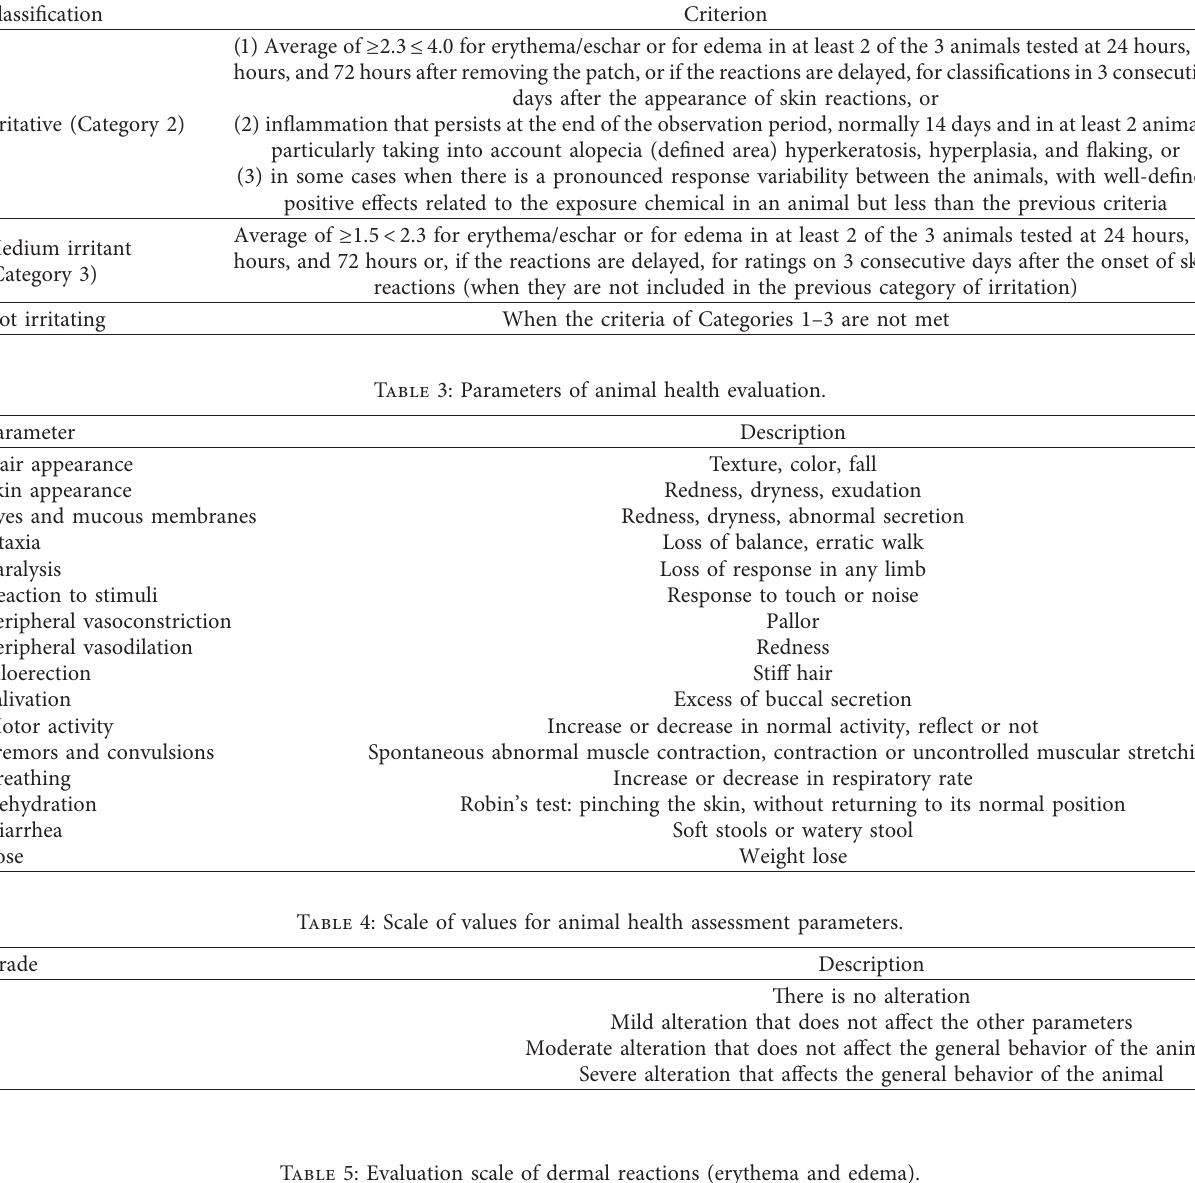
Table 2: Substance classification criterion tested according to GHS/OECD parameters.